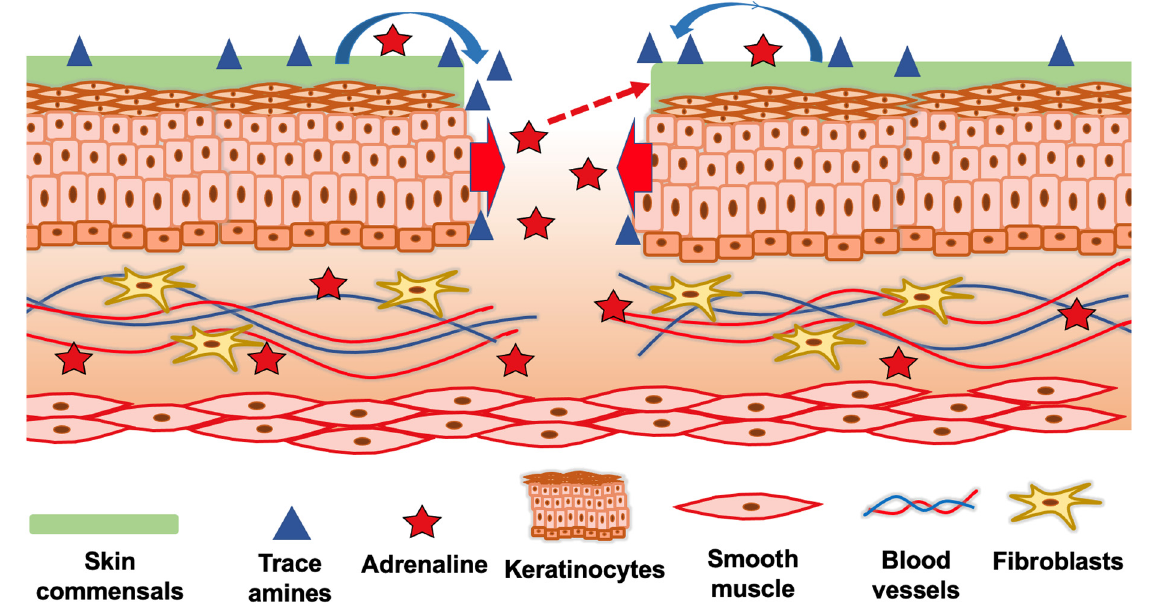
Figure 3. Interplay between trace amines (TAs) and adrenaline in wound healing. An injured skin tissue triggers an increased adrenaline level locally and systemically. The prolonged adrenaline exposure in the wound might hinder the healing process, mainly due to β 2-AR activation. Some skin commensals are able to produce TAs (blue bent arrow), which act as β 2-AR partial antagonists and help to accelerate the wound healing. On the other hand, adrenaline is also able to activate QseBC-regulated pathways and thus promote virulence traits of some members of the skin microbiota (red dashed arrow) that may delay wound healing.